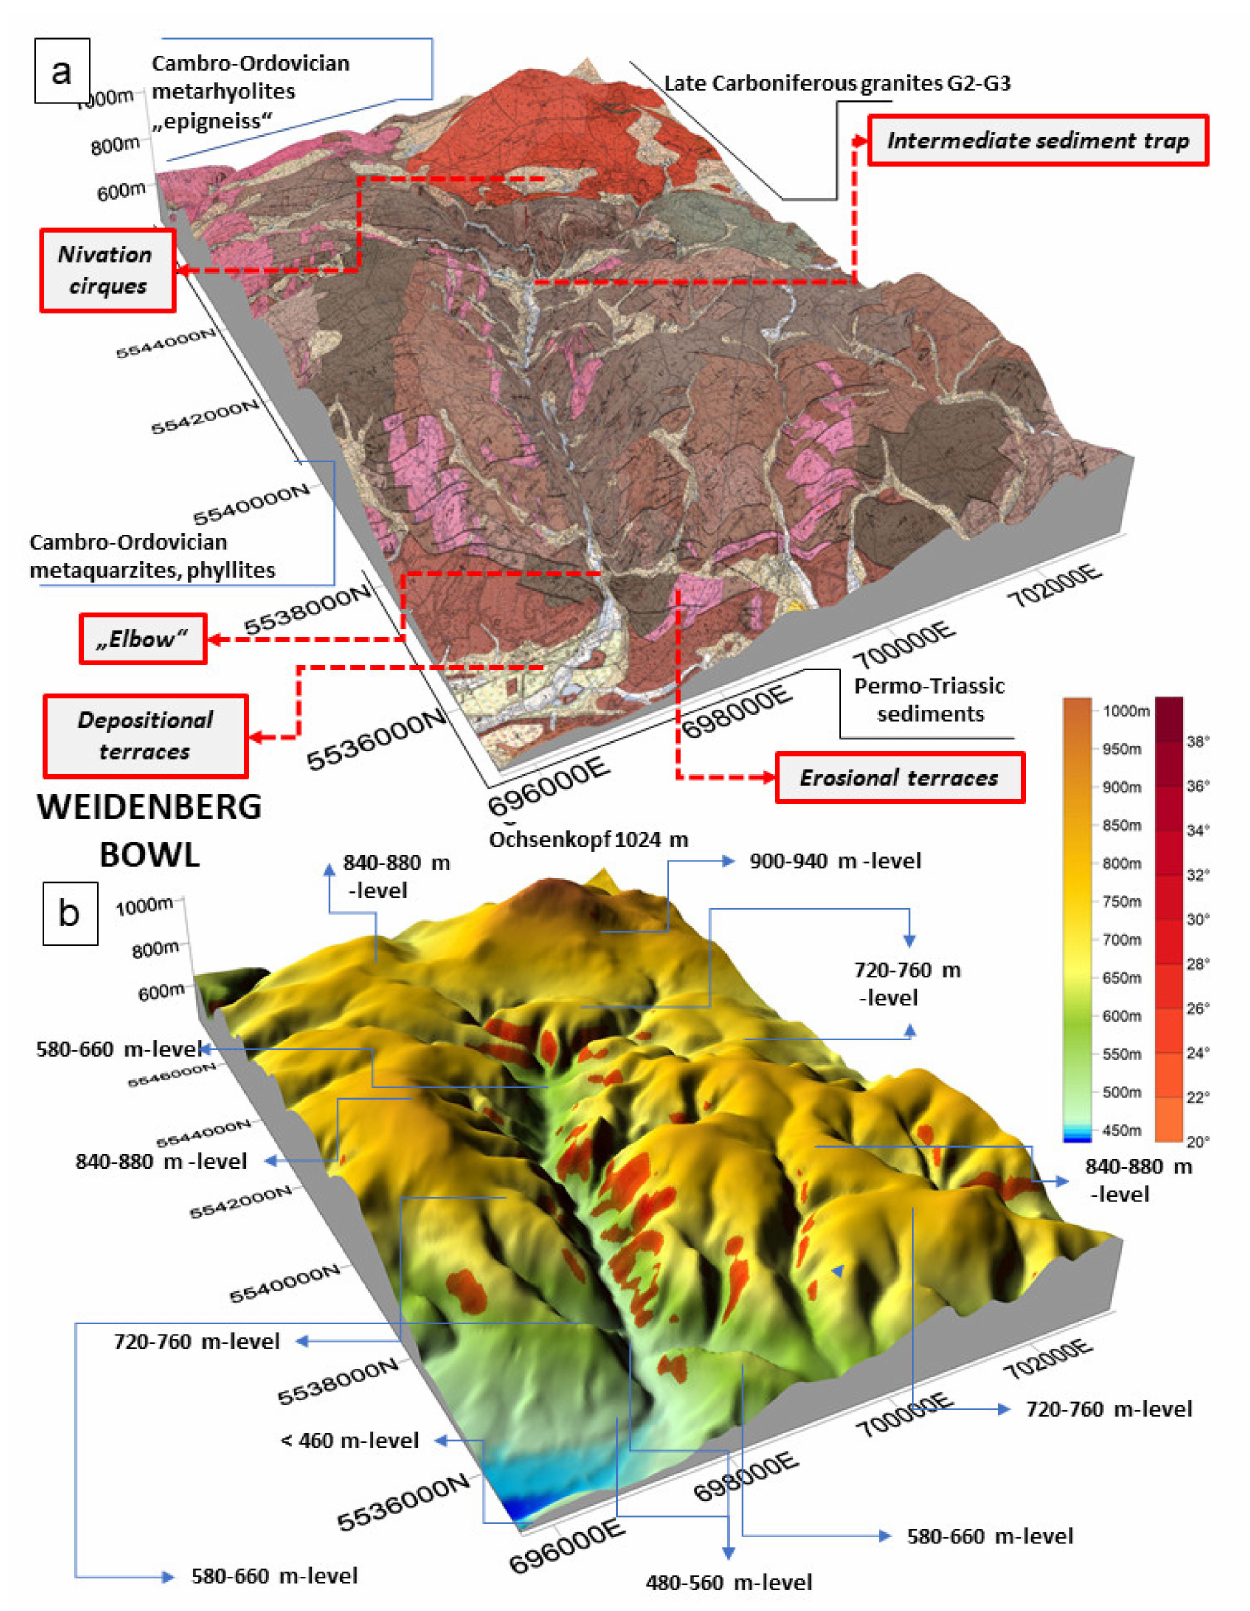
Figure 5. The drainage system of the Fichtelgebirge Anticline (Table 1-LGG-type): ( a ) Geology and the geomorphological setting; ( b ) Excerpt of the topography and the level of paleosurfaces of ( a